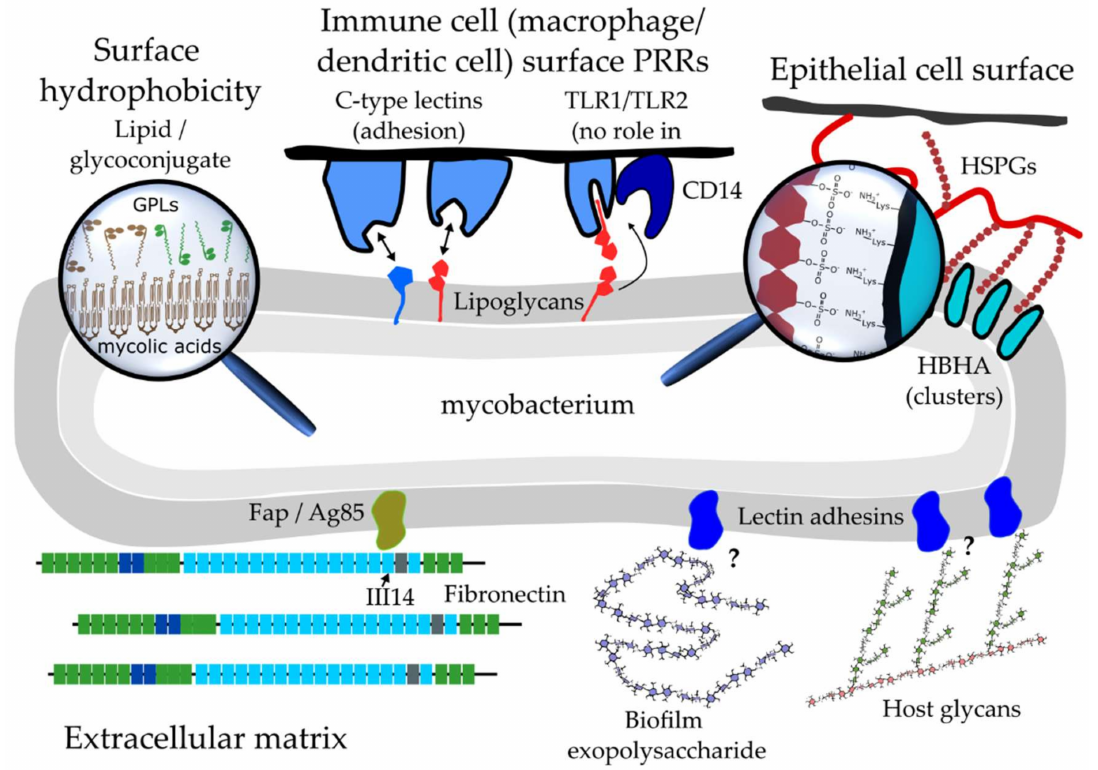
Figure 3. How mycobacteria control adhesion. Sequestration of lipids into nanodomains on the cell surface, as observed for glycopeptidolipids (GPLs) in Mycobacterium abscessus [81,137], may control hydrophobic interactions with foreign surfaces. In the same line, the surface exposure of specific microbial-associated molecular patterns (MAMPs) control interactions with pattern recognition receptors (PRRs). Here a distinction needs to be made between MAMP-PRR interactions that facilitate adhesion and those that play other roles. For example, TLR1/TLR2 interact with the hydrophobic acyl chains of their MAMP ligands, requiring their extraction out of the mycobacterial surface layers by accessory molecules such as CD14. Hence, the lack of an anchorage point on the bacterial surface disqualifies these interactions from playing a direct part in adhesion. On the other hand, PRR’s such as certain C-type lectins, including the mannose receptor, DC-SIGN and Dectin-2 bind the saccharide head groups of mycobacterial MAMPs whose hydrophobic acyl chains remain anchored within outer envelope layers. Such interactions play a direct role in mycobacterium-host cell binding and subsequent internalization of the bacteria. Specialized surface proteins called adhesins bind to specific host factors. Clustering of adhesins, such as heparin-binding haemagglutinin adhesin (HBHA), increases avidity of their interactions with heparin sulfate proteoglycans (HSPG), enhancing adhesion to epithelial cells. Adhesins, such as the fibronectin attachment protein (Fap) and members from the antigen 85 complex, drive adhesion of extracellular matrix components. We hypothesize that yet-unknown-carbohydrate-binding (lectin) adhesins bind to exopolysaccharide components of the biofilm extracellular matrix and/or to host